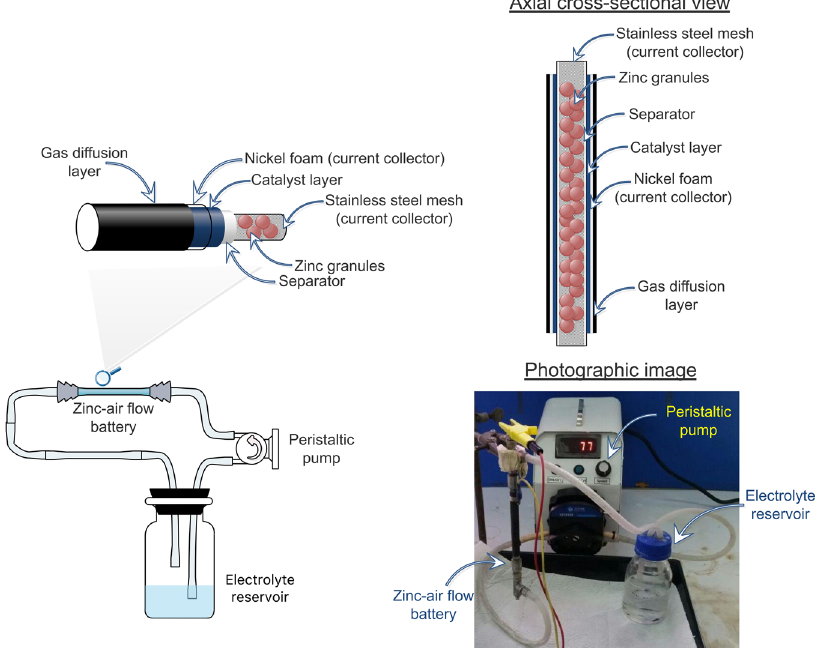
Figure 1. A schematic diagram and photographic image of the zinc-air flow